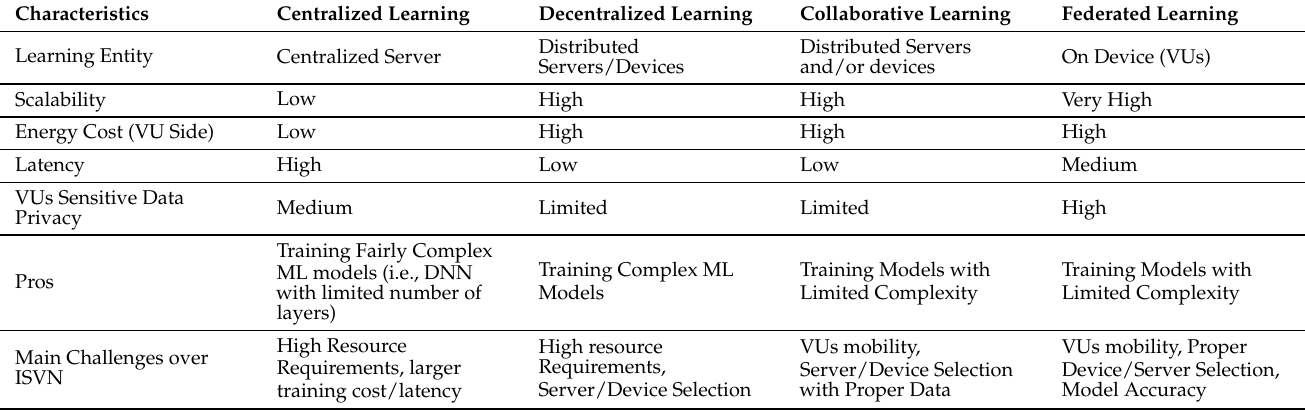
Table 2. Distributed ML models and corresponding